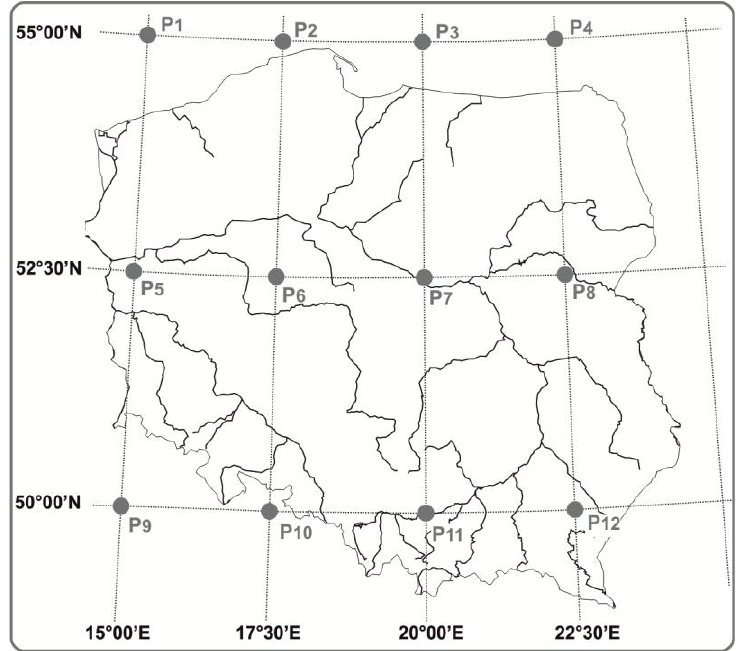
Fig. 1. Grid points used in the